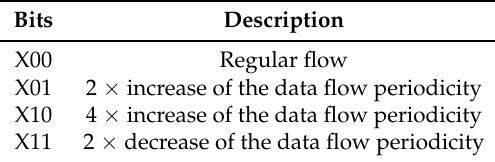
Table 1. Table indicating notification bits and degree of network behaviour change.